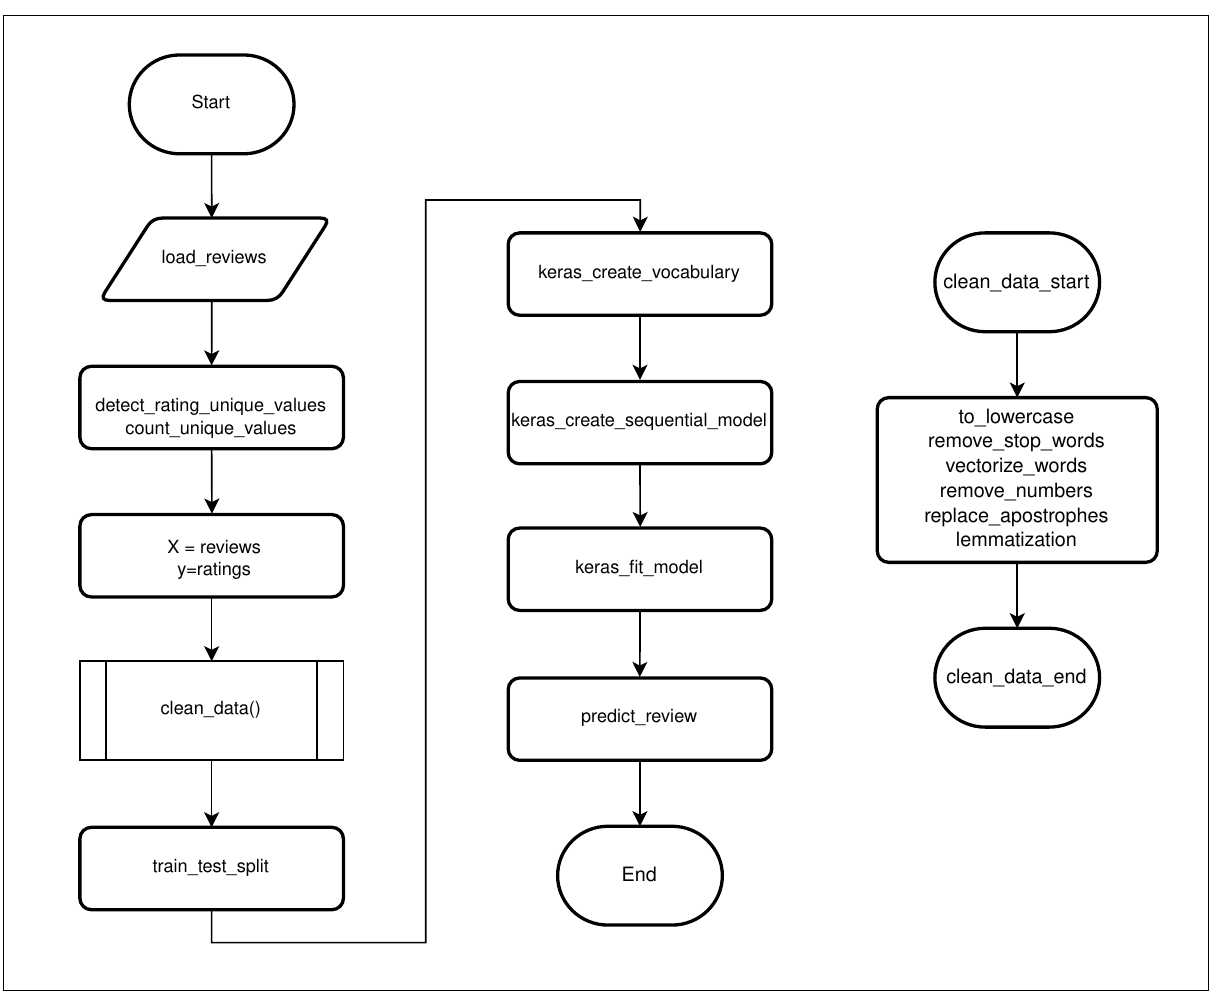
Figure 19. Rating predictor algorithm.